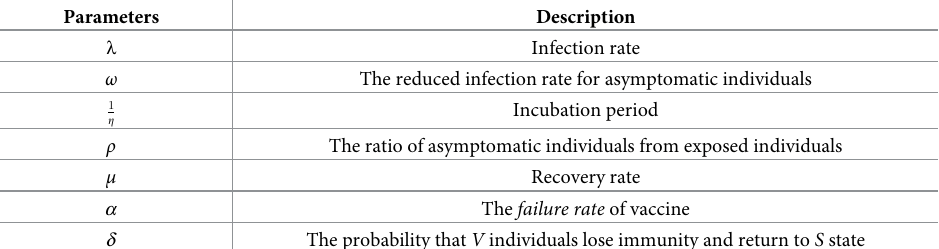
Table 1. The parameters used in SEVAIR